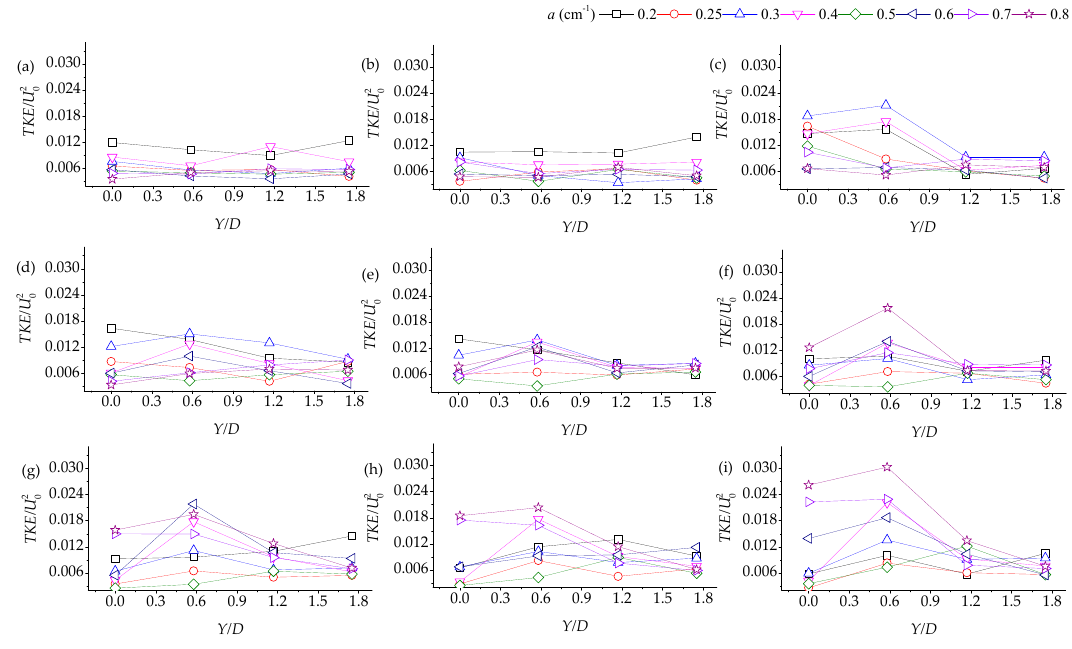
Figure 5. The lateral distribution of the dimensionless TKE . ( a ) X/D = − 3 ( b ) X/D = − 1.5 ( c ) X/D = 0.8 ( d ) X/D = 1.2 ( e ) X/D = 1.5 ( f ) X/D = 2 ( g ) X/D = 2.5 ( h ) X/D = 3 ( i ) X/D = 4.